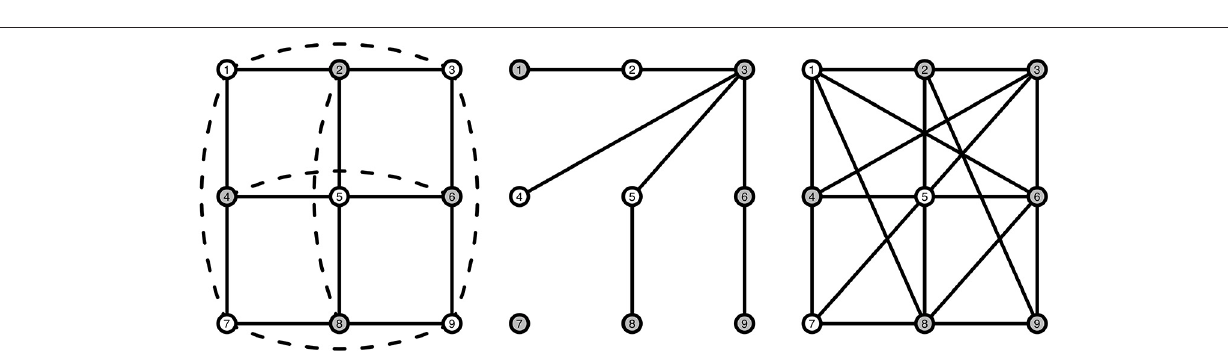
FIGURE 2 | Visualization of a grid structure (Left) , a random graph structure (Middle) , and a small-world structure (Right) . Gray nodes indicate the neighbors of the middle node in each graph. Solid lines indicate pairwise connections between nodes. Dashed lines are also pairwise connections, but have been curved and dashed as they are hidden behind other connections in a